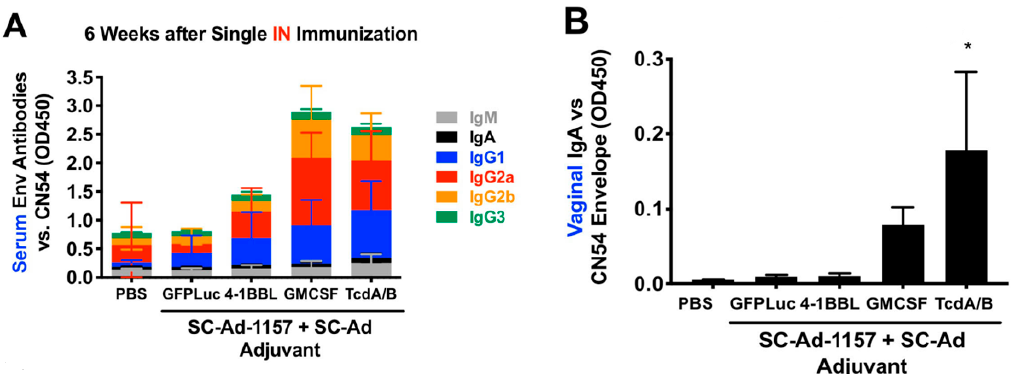
Figure 2. Effects of SC-Ad genetic adjuvants on clade C env antibody responses in mice after intranasal (IN) immunization. Groups of 10 female BALB/c mice were immunized with phosphate-buffered saline (PBS) or 10 9 vp of the indicated SC-Ads. Six weeks later, samples were collected for enzyme-linked immunosorbent assay (ELISA) vs. clade C CN54 gp140. ( A ) Sub-isotyping ELISA for the indicated samples at 1/200 dilution (low dilution used for low-sensitivity sub-isotyping kit). All IgG isotypes in the granulocyte macrophage colony-stimulating factor (GMCSF) and TcdA/B groups were significantly different than PBS by 2-way ANOVA. ( B ) ELISA OD450 levels are shown for 1/35 dilution of vaginal wash samples with detection by anti-IgA. * p < 0.05.